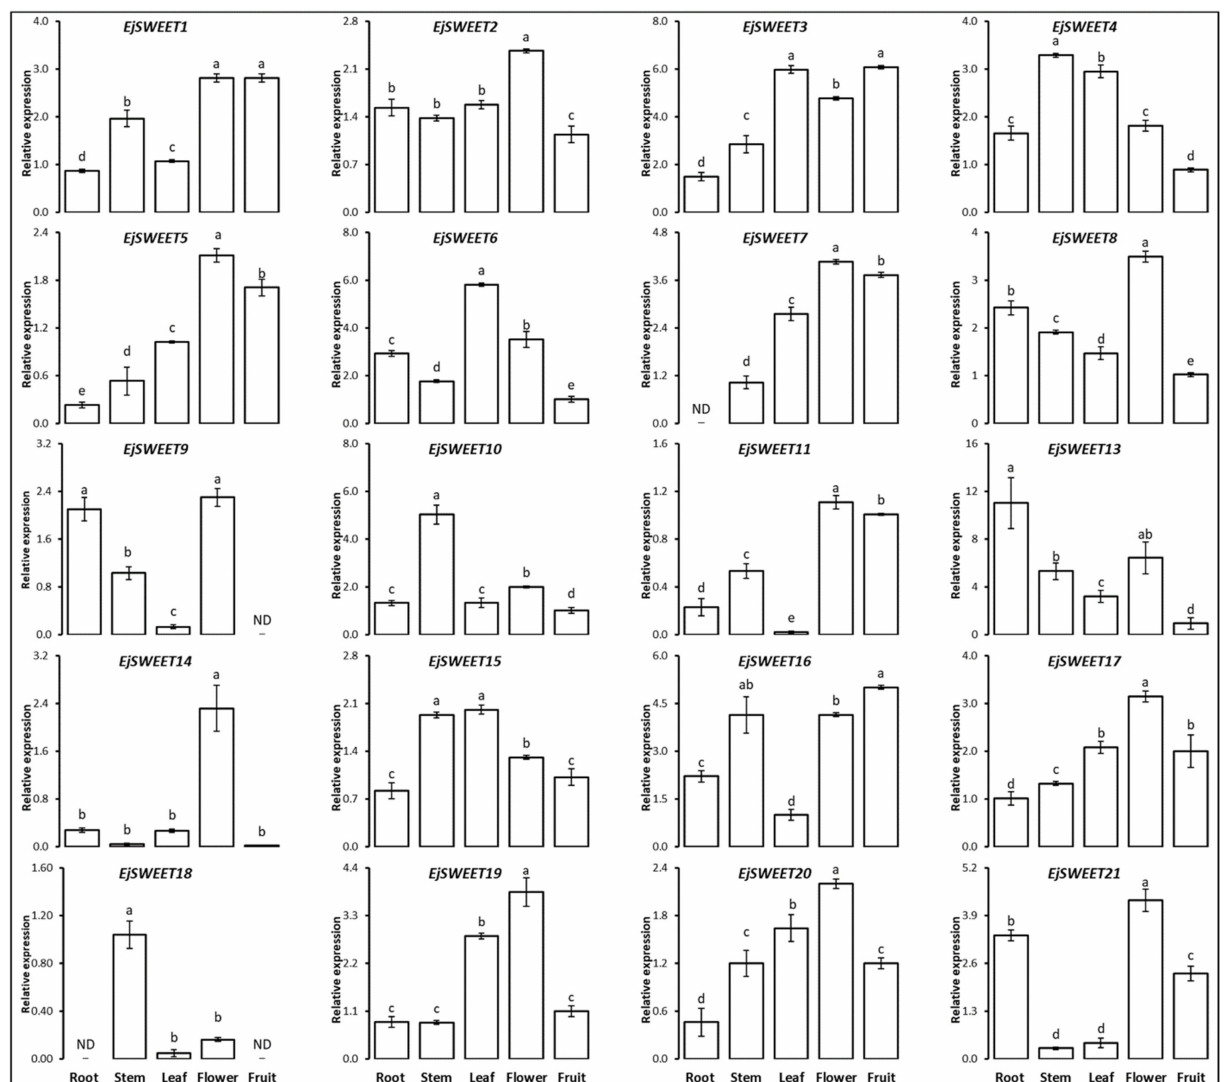
Figure 7. Relative expression levels of EjSWEETs in five tissues of loquat, i.e., root, stem, leaf, flower, and fruit. Significant difference among different tissues is denoted by different letters following the least significant difference (LSD) test ( p ≤ 0.05). Vertical bars show average ± standard error (6 replicates). ND—not detected. The genetic expression of EjSWEET12 was not detected in all loquat